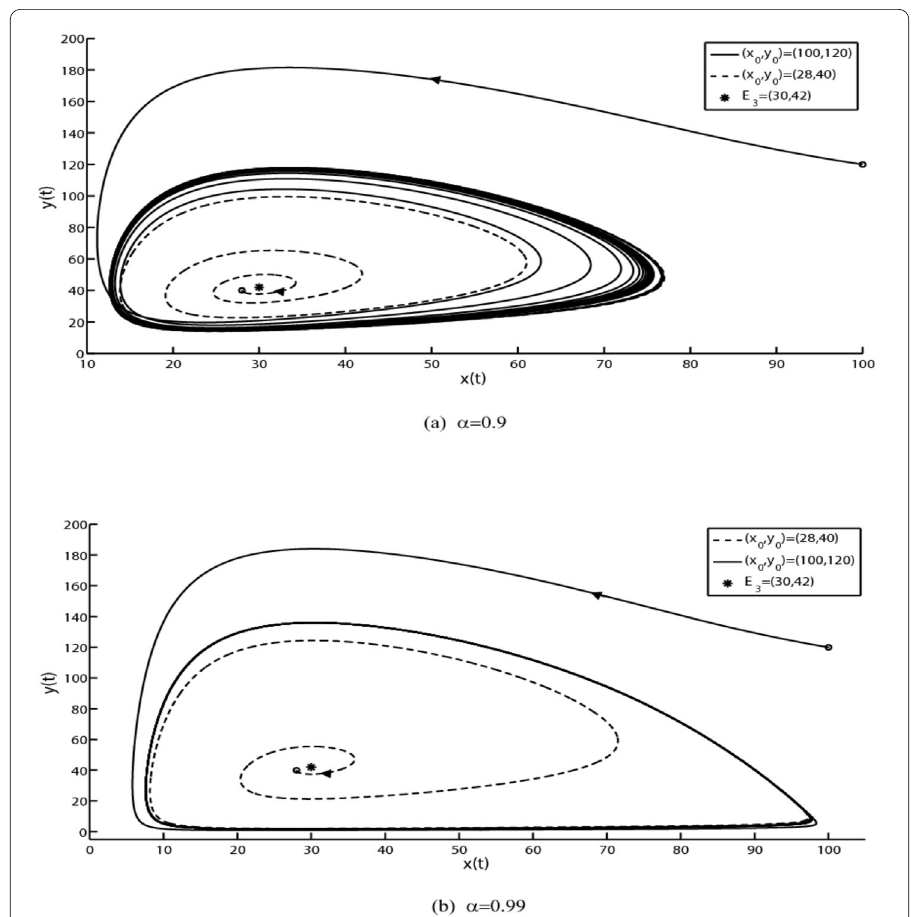
Figure 5 Effect of the derivative order α on the dynamic behavior of model (3) with the following parameters: s = 0.56, r = 0.02, K = 100, m = 2, a = 30, p = 1, and c = 0.5. ( a ) Derivative order α = 0.9 and ( b ) derivative order α =